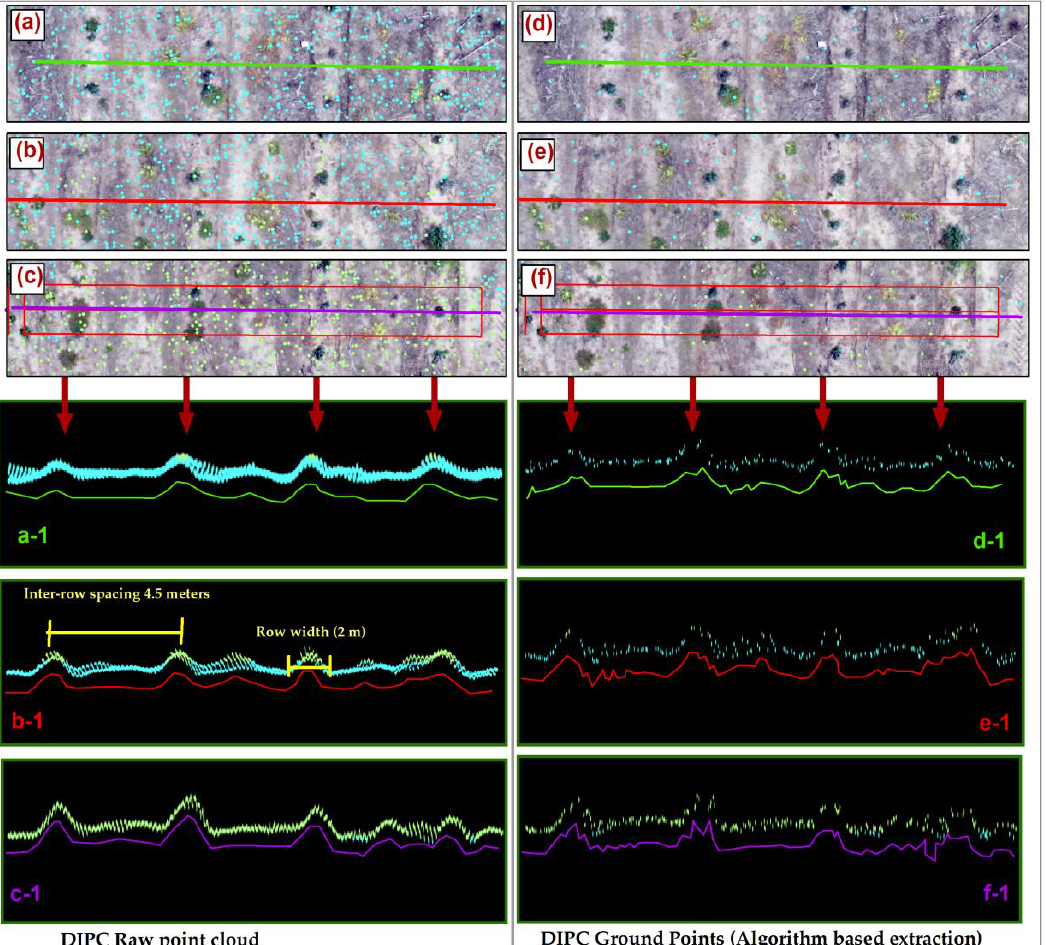
Figure 5. A raw DIPC vs. ground points extracted from DIPC. ( a – c ) Profiles of raw DIPC. a-1, b-1, and c-1 are 3D profiles of raw-DIPC and corresponding solid-lines of DSM surface profiles. ( d – f ) Profiles of ground returns. d-1, e-1, and f-1 are 3D profiles of DIPC ground returns and corresponding solid-lines of DSM surface profiles. The profiles were slightly o ff set to show respective point